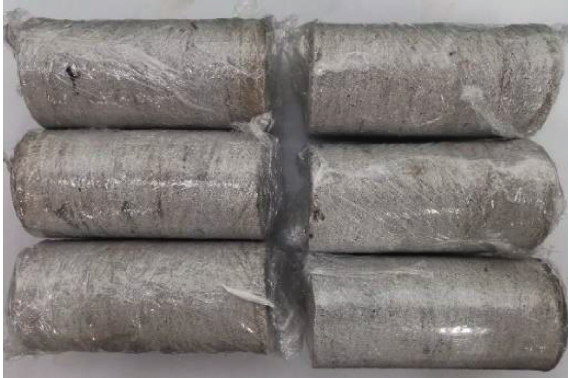
Figure 1: Some sandstone samples taken from coal